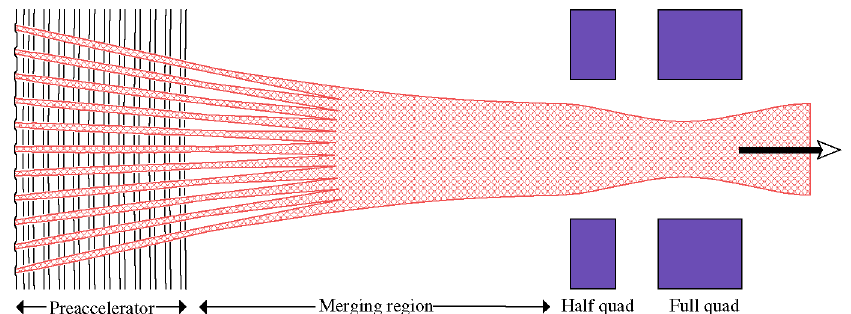
FIG. 1. (Color) Layout of the multibeamlet injector. Each of the beamlets is accelerated independently and then merged. The total beam is matched to the subsequent transport